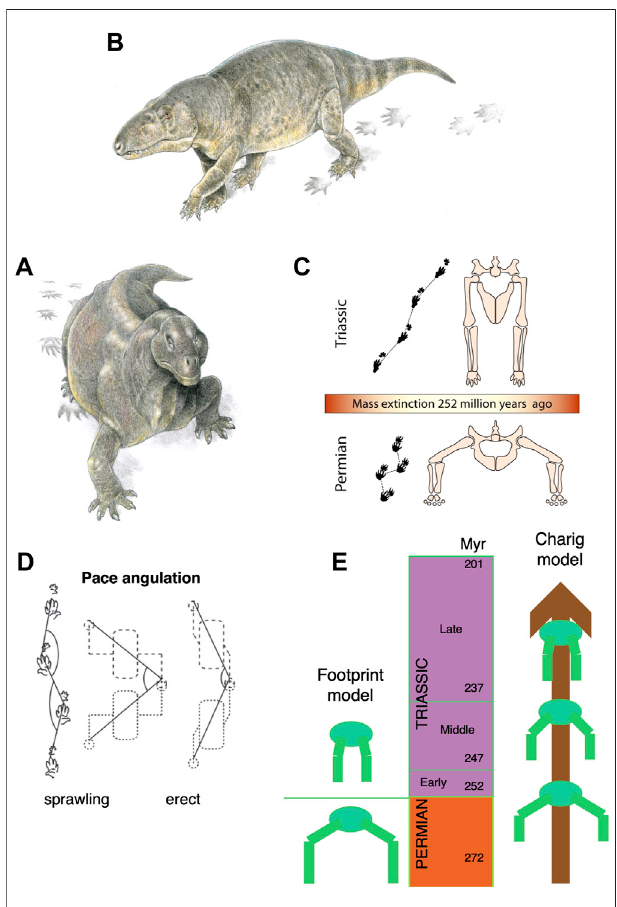
FIGURE 4 | Posture shift from sprawling to parasagittal, among synapsidsand archosauromorphs. (A) Asprawling synapsid, Moschops from the Late Permian. (B) An erect-postured archosauriform, Vjushkovia from the Early and Middle Triassic, both with tracks. (C) The transition from sprawling to erect posture across the Permian-Triassic boundary. (D) Measurement of pace angulation of tracks, showing sprawling and erect tracks,withsketchbodyandlimbs(valuesofpaceangulation138 o indicatean erect posture). (E) Contrast of the instant switch from sprawling to erect posture across the Permian-Triassic boundary, 252 Ma (left) with the classic Charig (1972) model of a more prolonged postural shift, occurring through much oftheTriassic.Panels Aand BarebyJimRobins; CbySimonPowell; D is from Kubo and Benton (2009), and E is original; all from Benton